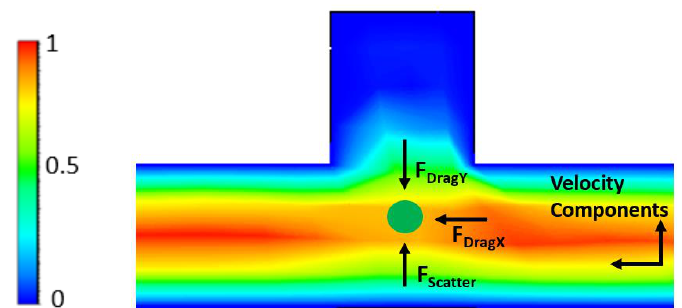
Figure 5. Forces acting on a microbead (green circle) in the orthogonal force design. Fluid simulation was performed in Ansys Fluent. The color spectrum corresponds to various flow velocities with red being high and blue being low.